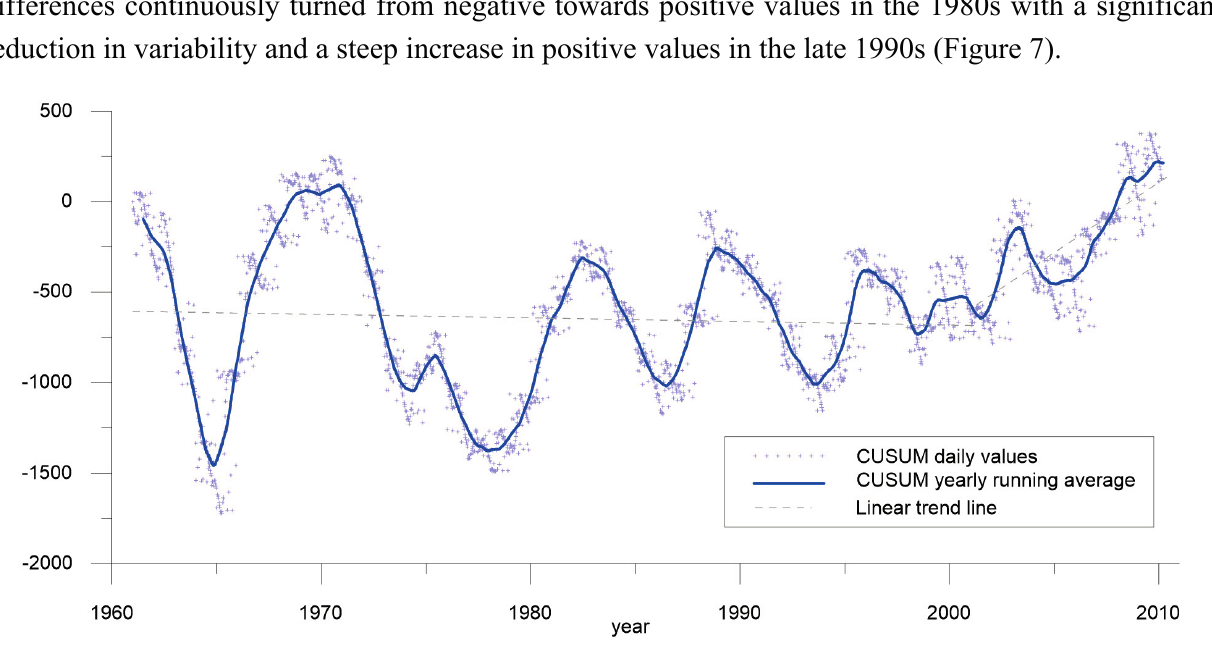
Figure 7. CUSUM analysis of daily discharge (Q d ) during 1961-2010. The trend lines are based on results from Table